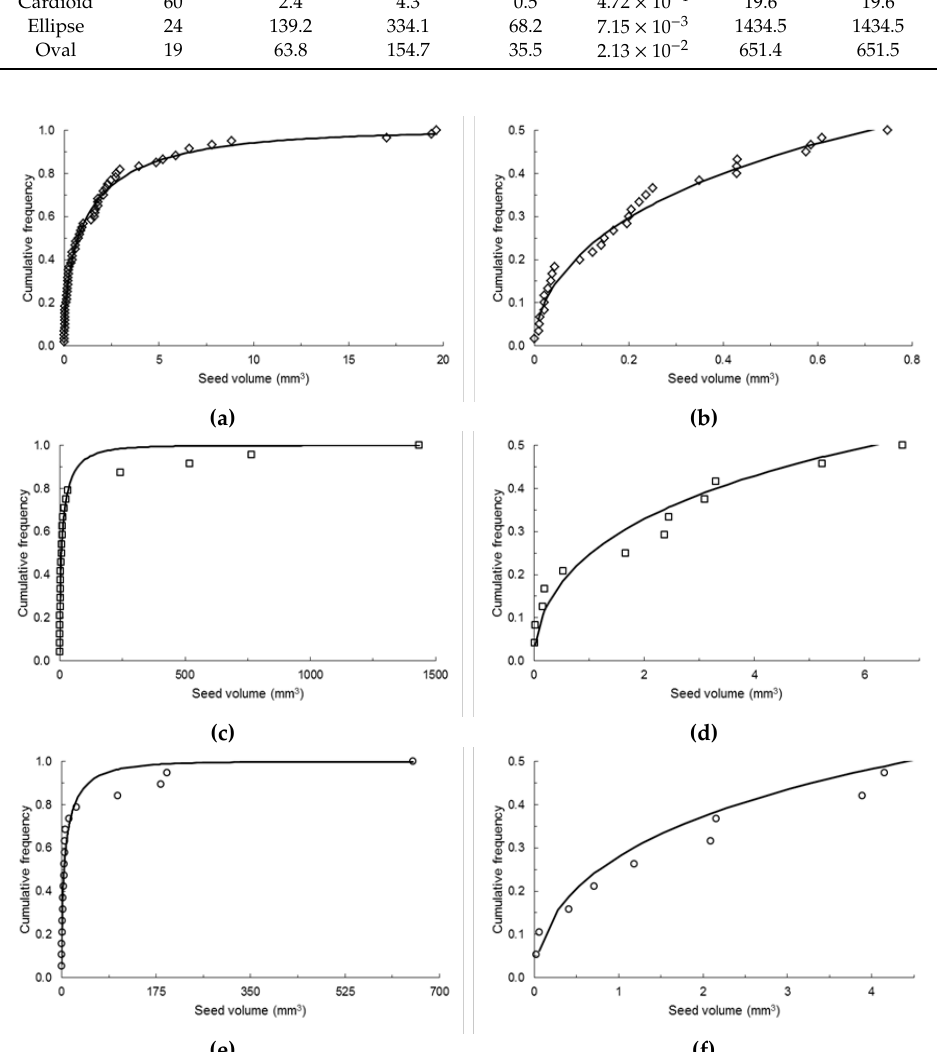
Figure 1. Observed (symbols) and fitted (curves) size–number cumulative relative frequency of species with: ( a , b ) Cardioid seeds; ( c , d ) elliptic seeds; ( e , f ) oval seeds. Left panels show the whole range of cumulative frequencies; right panels show only the two first quartiles. Table 2. Result of Scheffé’s test ( P < 0.05) showing differences in size between the seed groups.